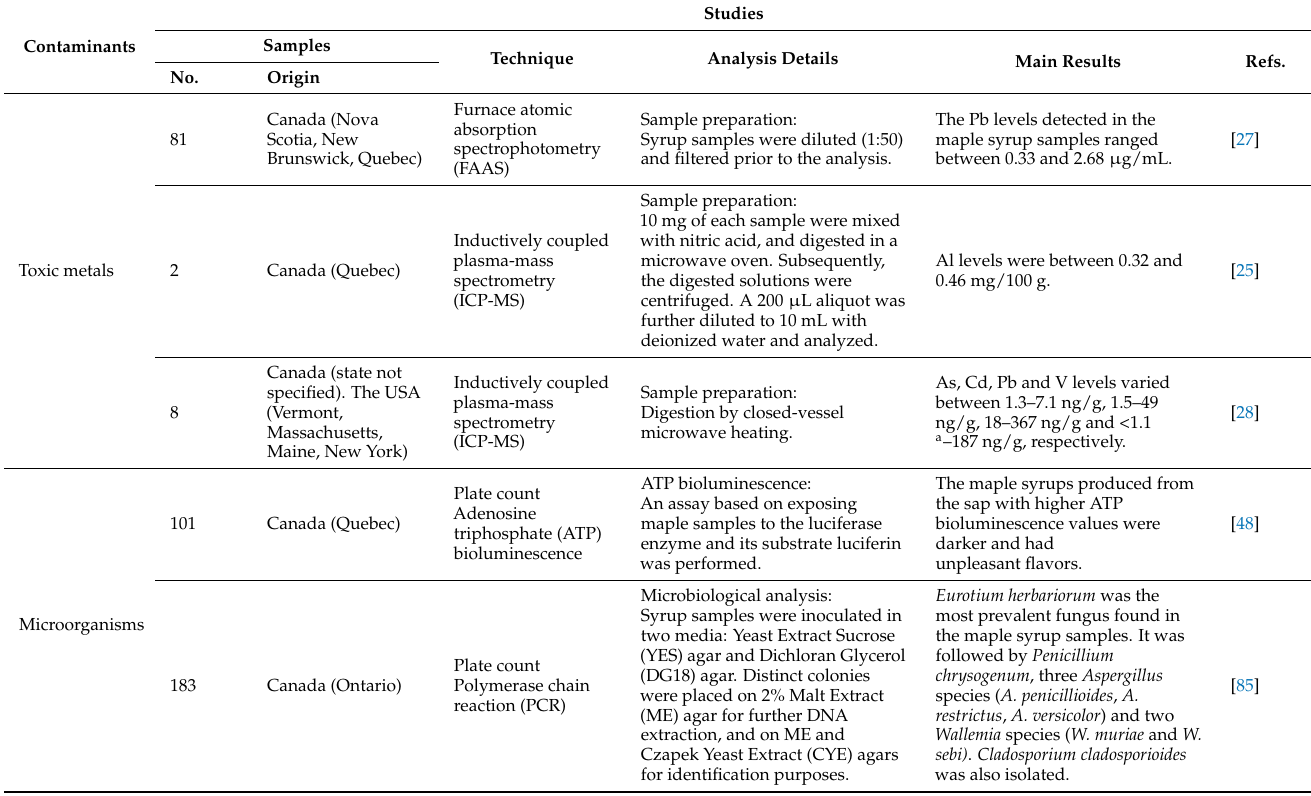
Table 4. Detection of contaminants in maple